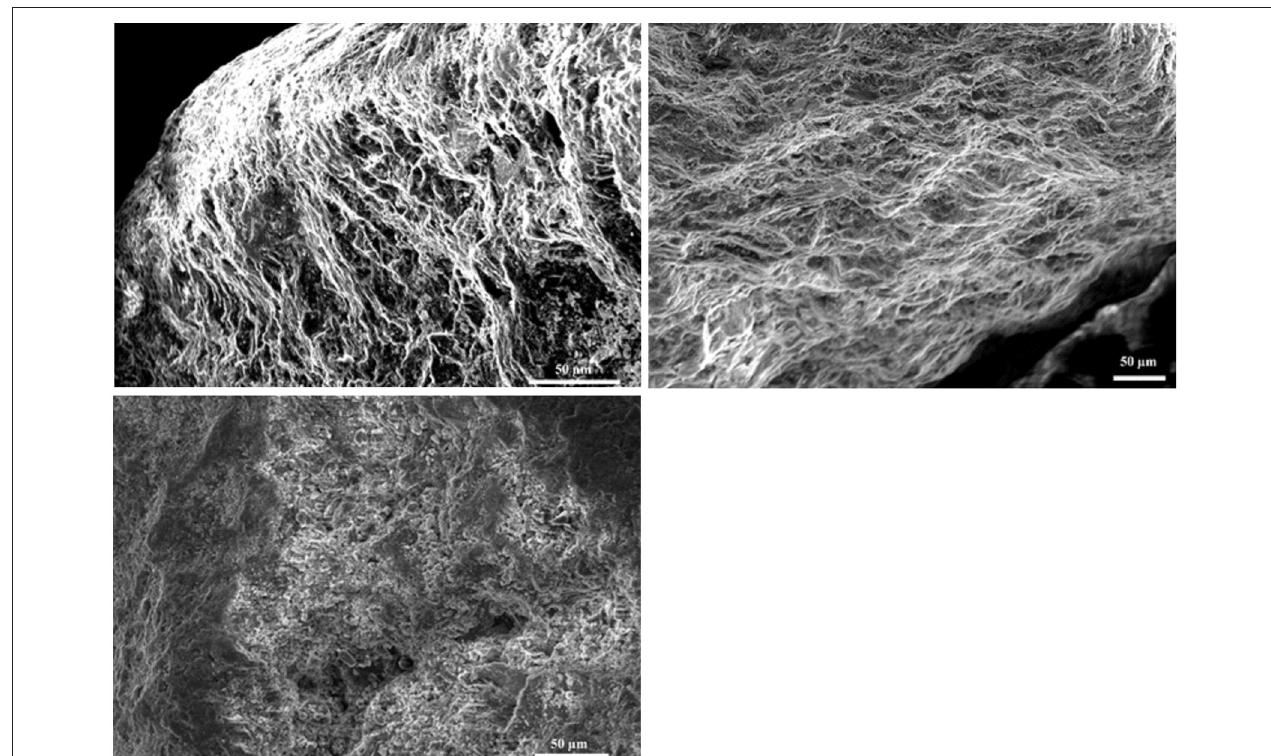
FIGURE 3 | Images obtained by SEM microscopy. Upper left is a SEM image of basalt from the flight experiment and upper right a SEM image of basalt from the ground experiment. The control, lower right, is a SEM picture of the basalt after the 3 month experiment where no cells have been added and the surface of the basalt can be seen. Both in ground and flight experiment, biofilm covers the basalt surface. For the flight, less thick biofilm is seen as the surface is still visible and the biofilm does not cover the whole surface such as seen in the ground